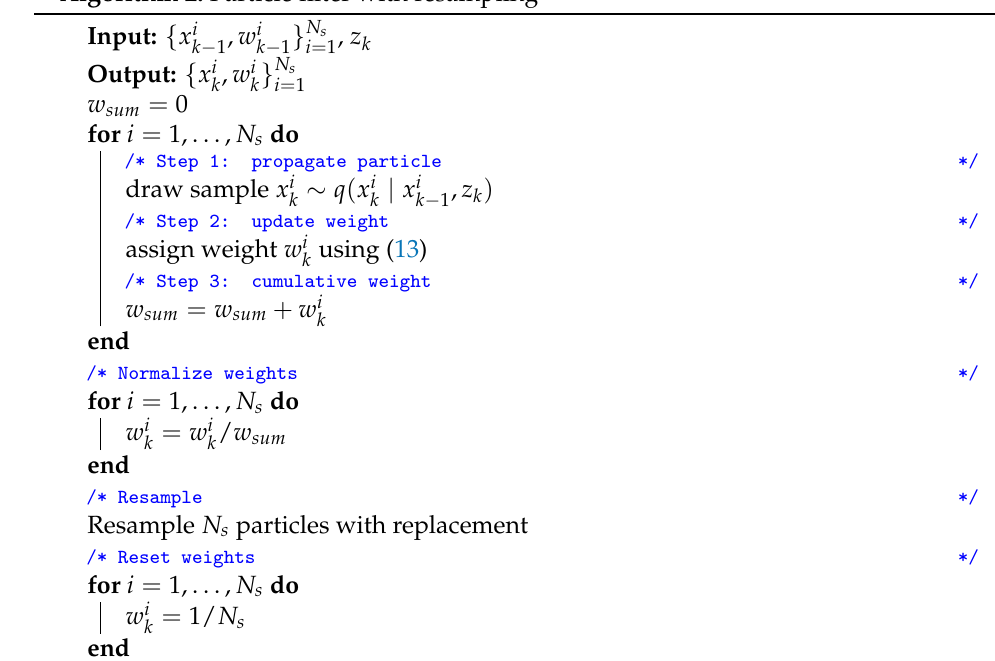
Algorithm 2: Particle filter with